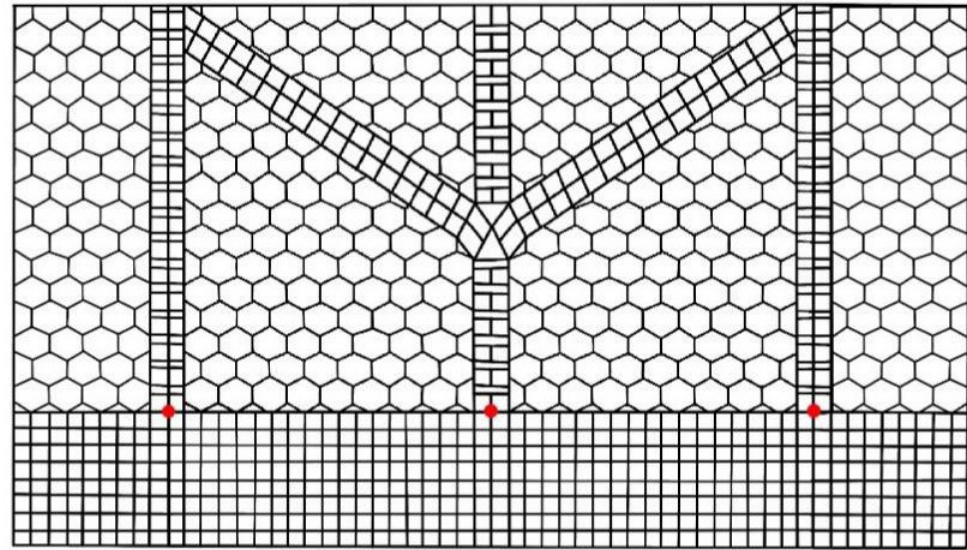
Figure 27. Model I with additional column positions.